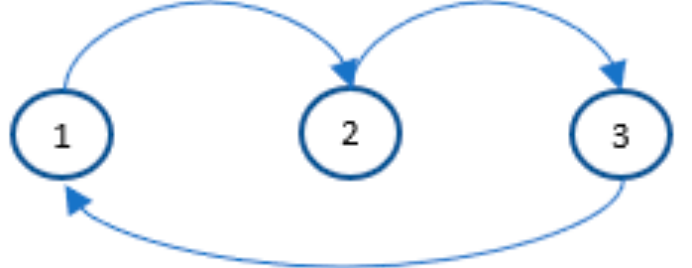
Figure 5. Communication model example.